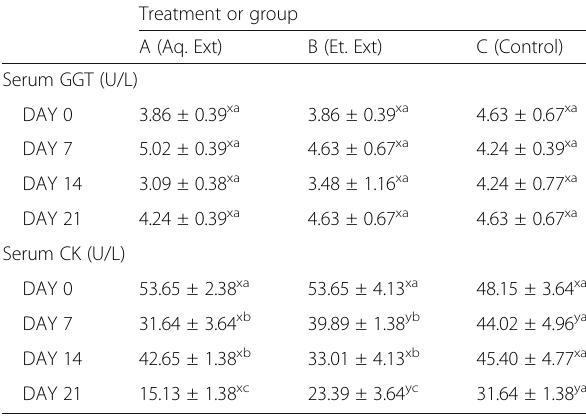
Data represent Means ± S.E.M ( n = 6). Means with different letter a, b, c, superscripts, along column, are significantly different ( p < 0.05). Means with different letter x, y superscripts, along row, are significantly different ( p < 0.05)